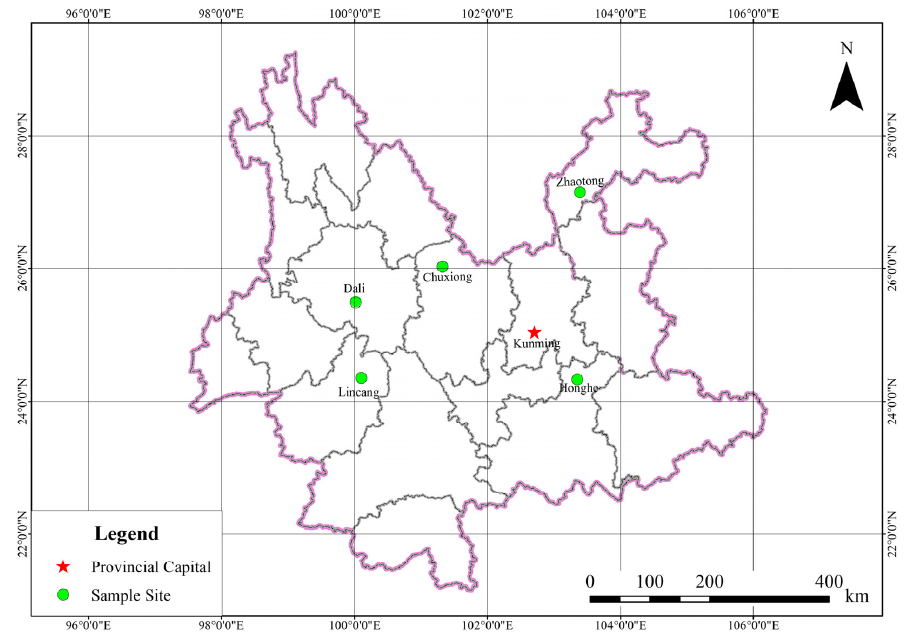
Figure 1. Map of sampling locations in the experiment areas in southwestern China. Diagram showing the collection of soil and root samples from naturally grown and cultivated walnut trees sites in each of five locations, which is indicated by the blue circle. The naturally grown and cultivated walnut trees areas are approximately 3–6 km apart, which were put in a circle in the same location. Fifteen healthy walnut trees (five trees each) at the reproductive stage were randomly selected from three replicated locations of a naturally grown and cultivated trees sites in each of five geographical locations.